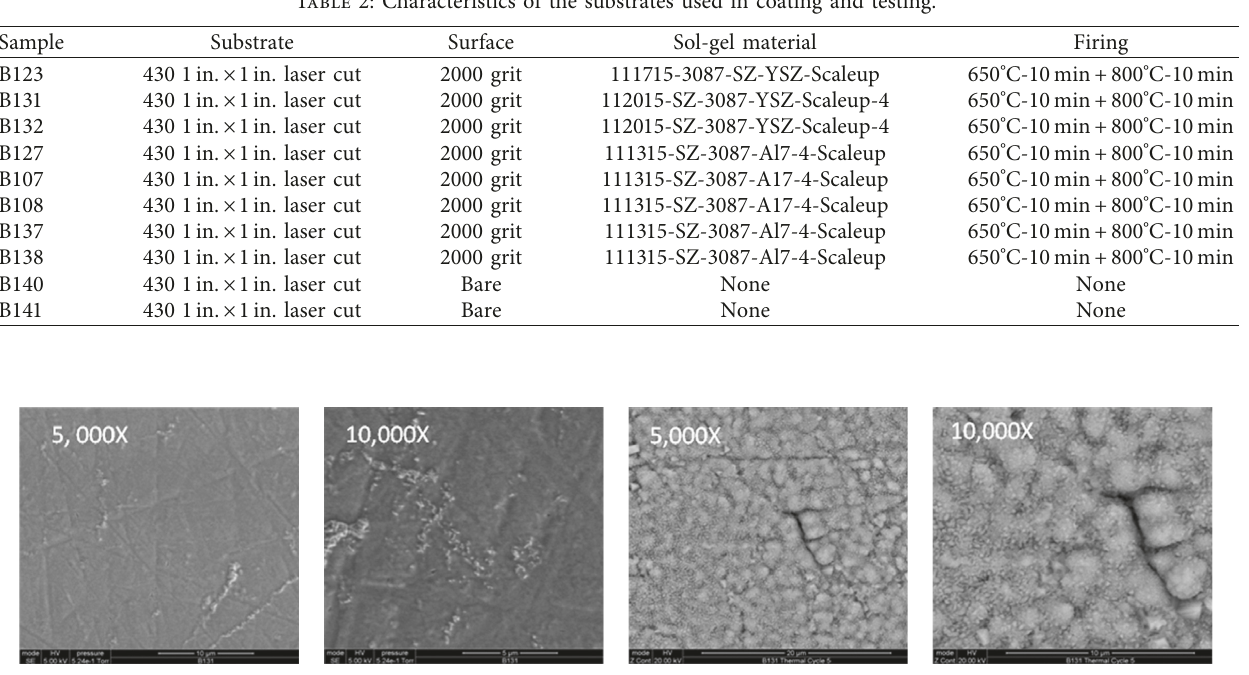
Table 2: Characteristics of the substrates used in coating and